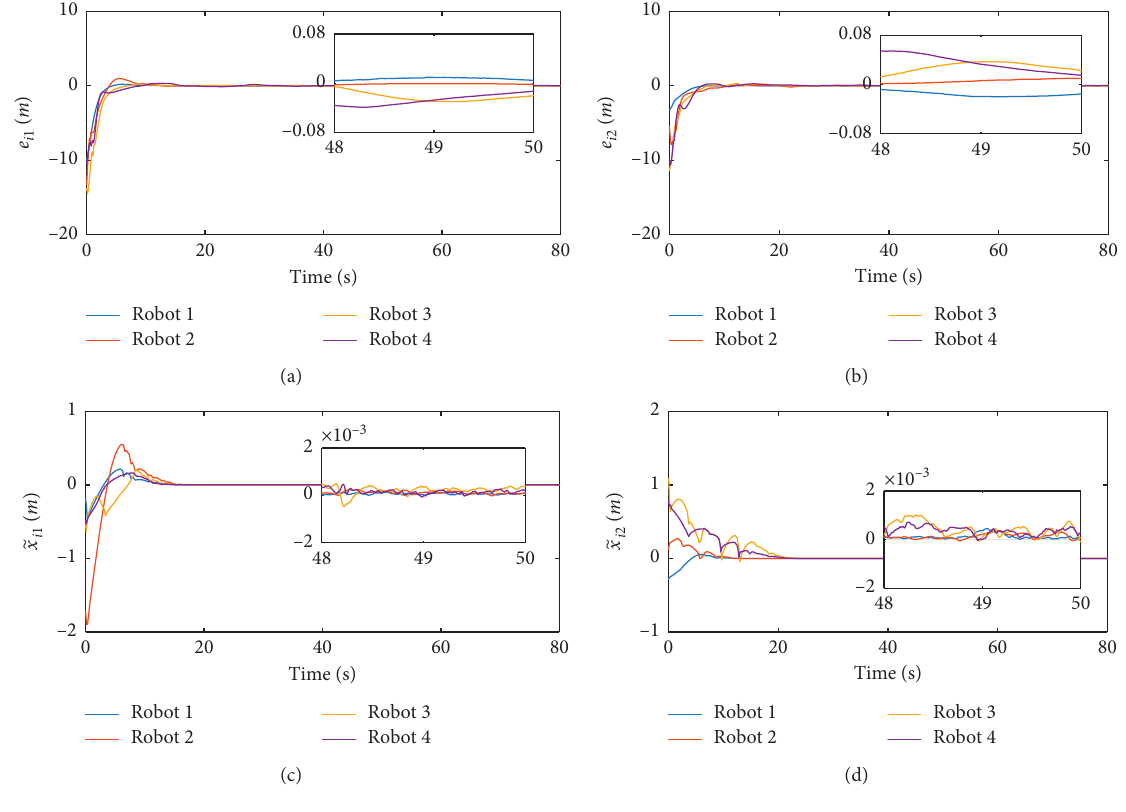
e 􏽥 x i 1 (a) i 2 (b) i 1 (c), and